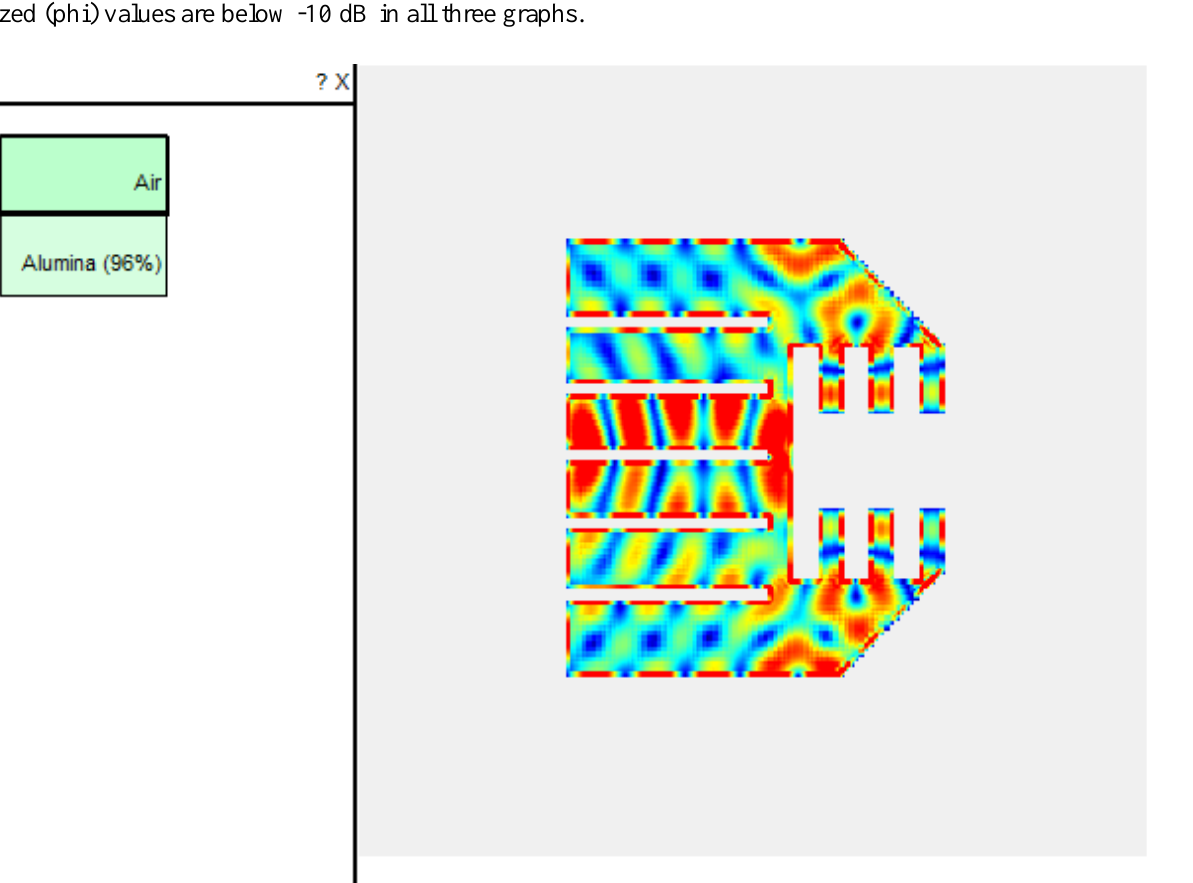
Figure 1. Top view of the antenna with current dissipation